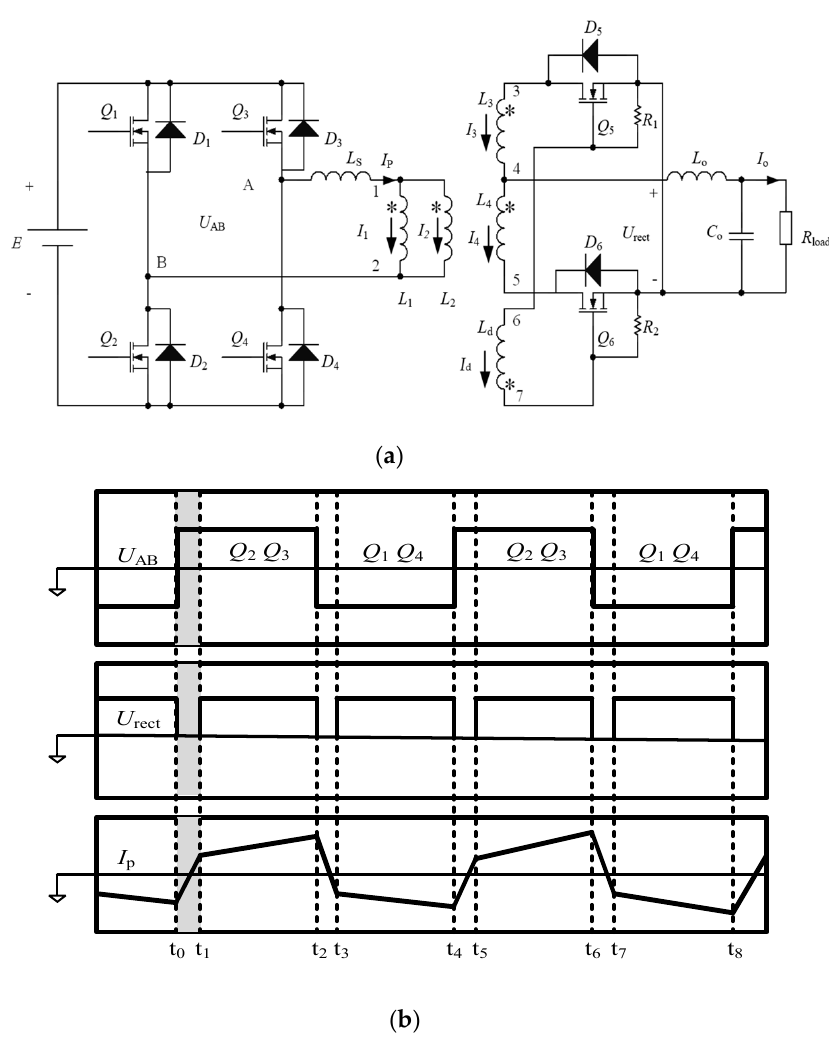
Figure 3. The proposed contactless bus converter. ( a ) Main circuit. ( b ) Key waveforms.